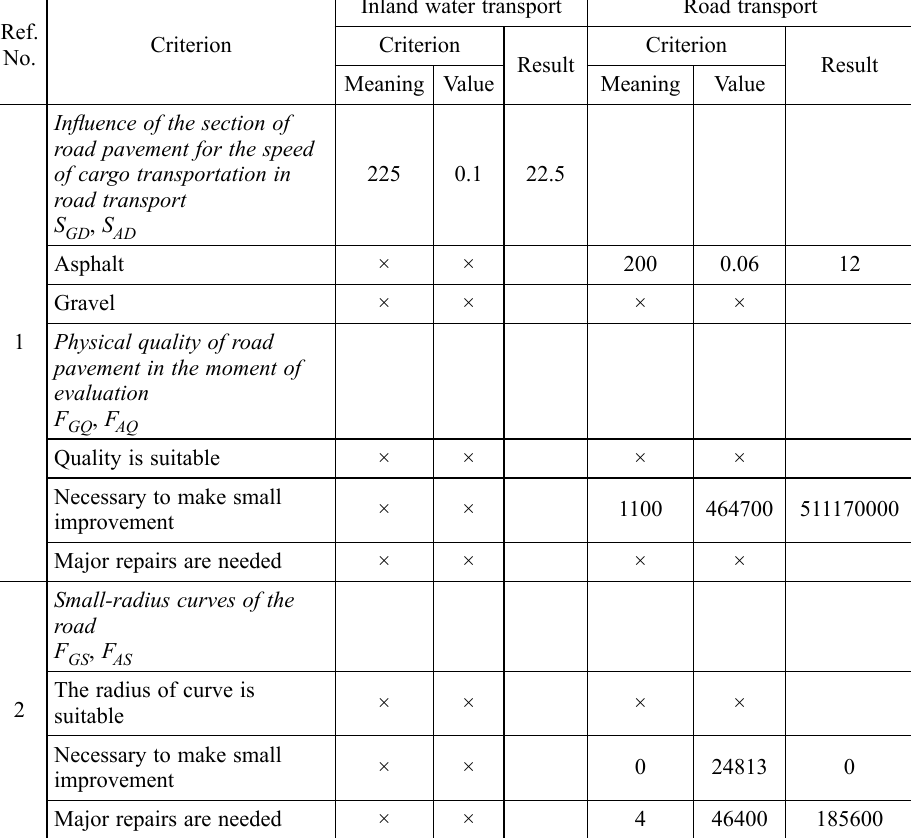
Table 1. Multimodal (inland waterways and road transport) route evaluation criteria